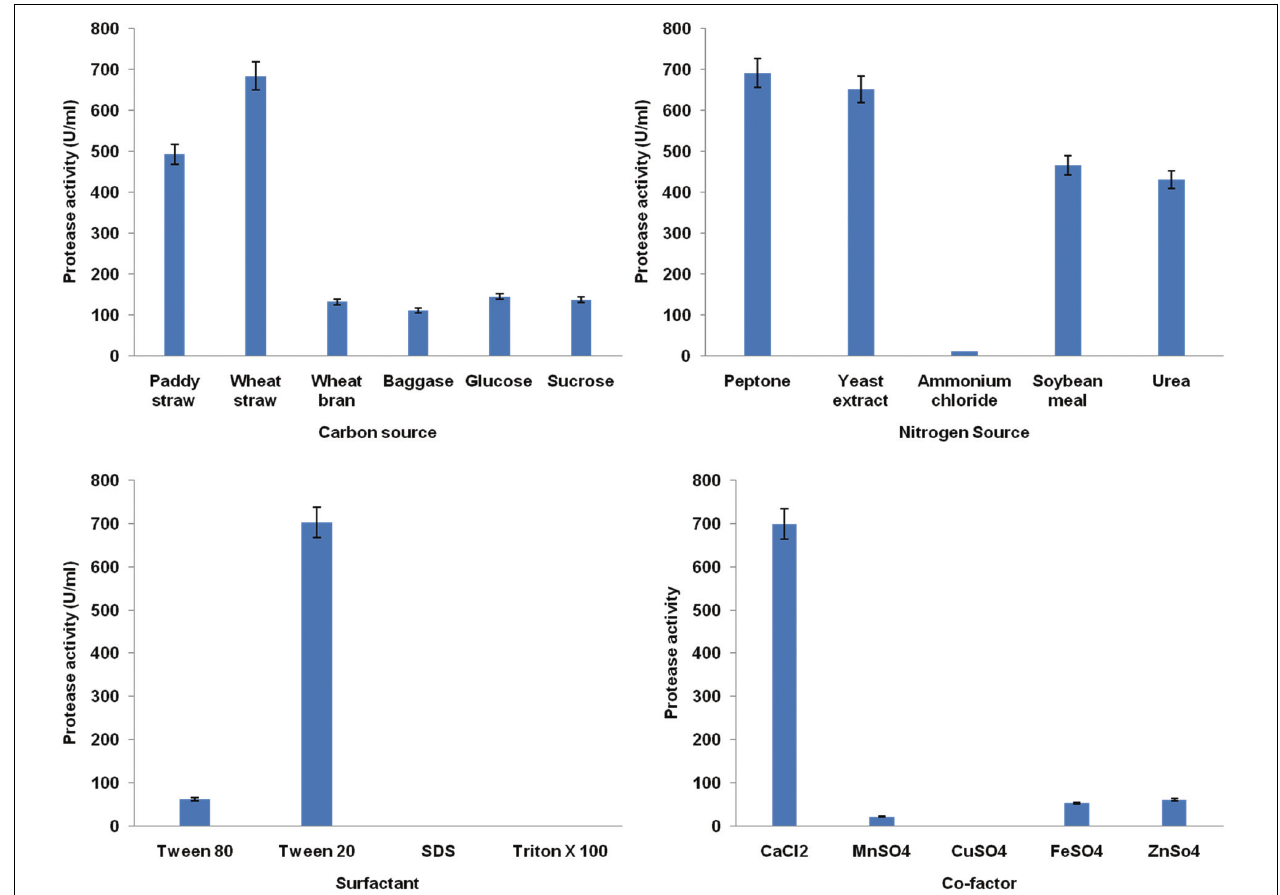
FIGURE 2 | Effect of media components (carbon source, nitrogen source, co-factors and surfactants) on protease production by B. pumilus 27 using one parameter at time approach.